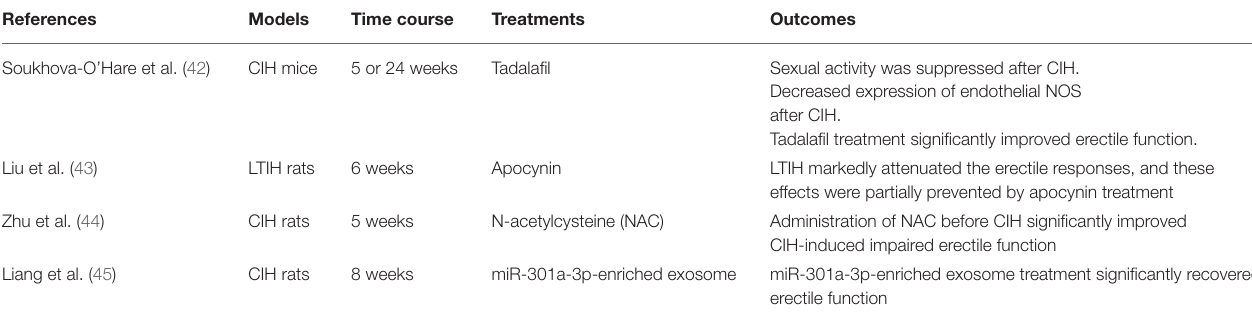
TABLE 2 | The characteristics of the included basic science